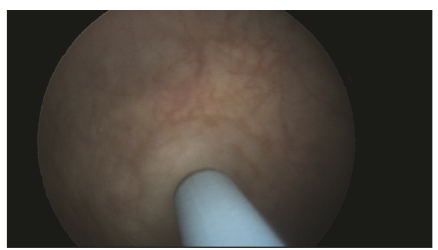
Figure 2: Injection of needle through uroepithelium.